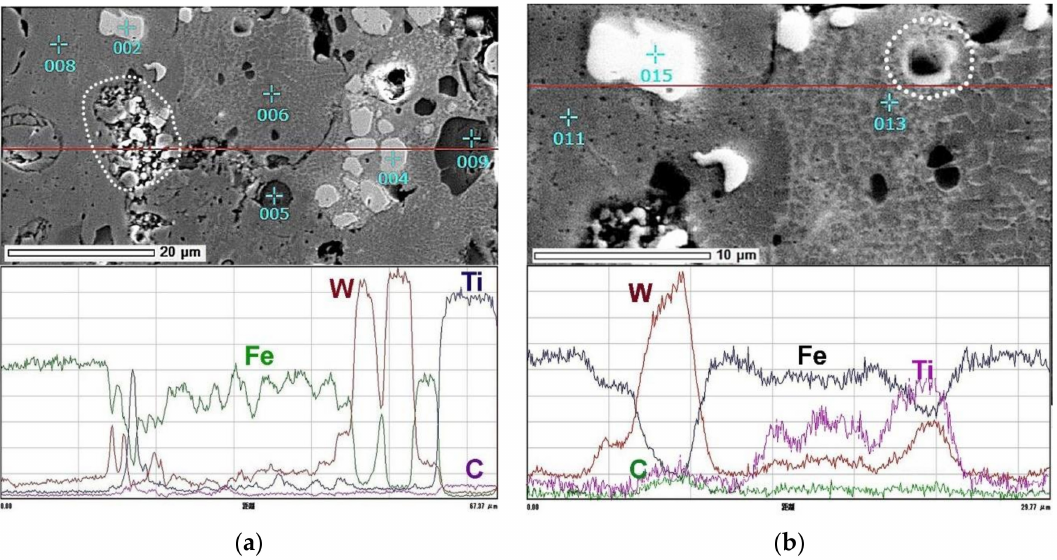
Figure 9. The EDX-profiles of C, W, Ti and Fe within the coating: ( a ) across WC and TiC carbides, ( b ) across carbide-free matrix and “carbide network” matrix.